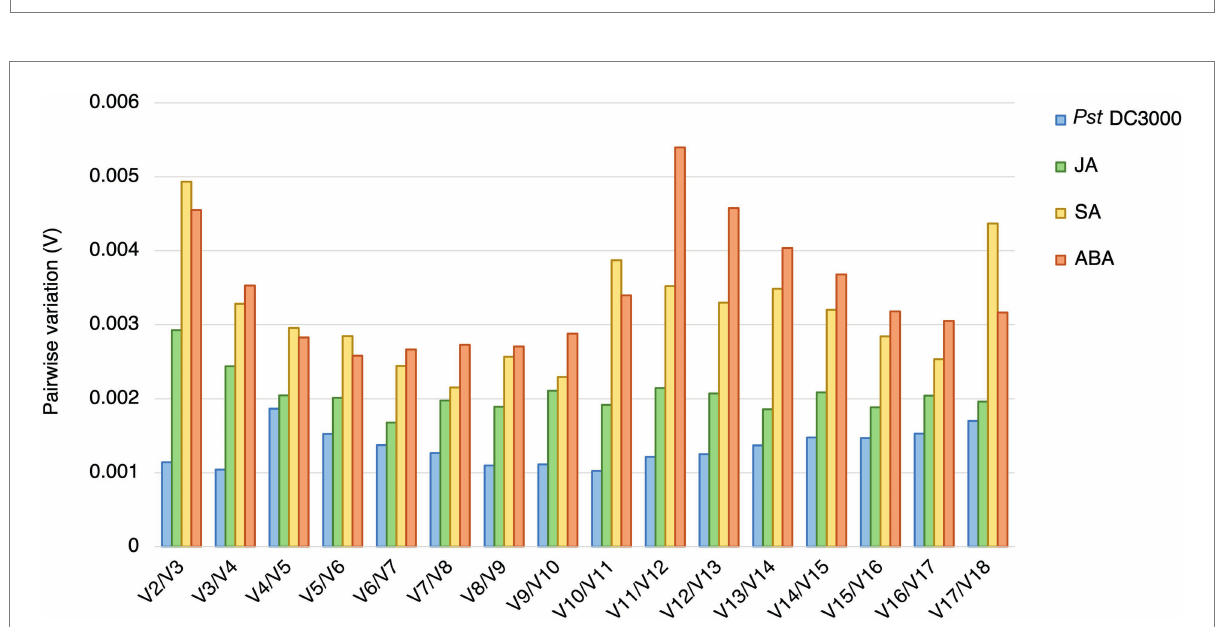
FIGURE 7 Pairwise variations (V) of the candidate reference genes. The pairwise variations (V) of the candidate reference genes calculated using geNorm, and V = V n /V n + 1 , where n is the number of reference genes required for expression normalization in RT-qPCR. The threshold value of V for achieving the optimal number of reference genes for RT-qPCR normalization is 0.15. All the candidate genes had V values well below the threshold value under all the treatments, indicating a minimal number of reference genes from among these candidates is required for normalization in